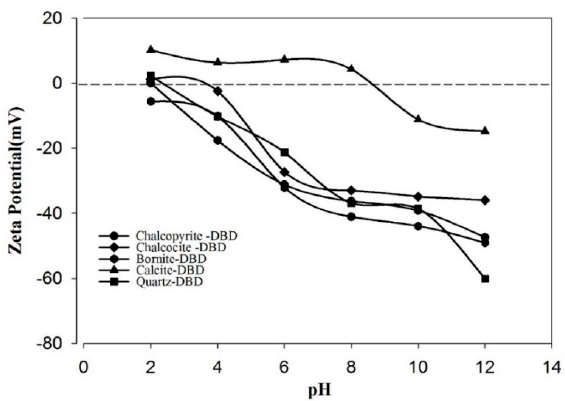
Figure 5. The zeta potentials of minerals as a function of pH at DBD concentration 5 × 10 − 5 M.